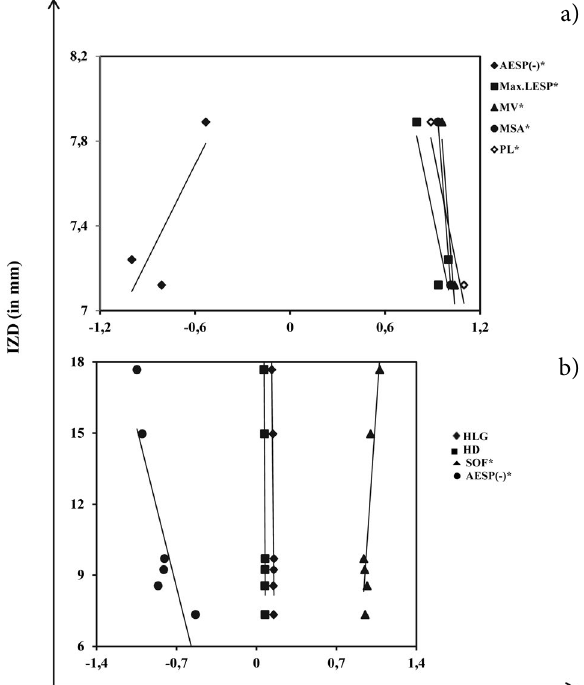
Figure 6. The correlation between descriptors and the IZD values of the ligands 4c , f , h and 4a – c , e , f , h against Gram-positive bacteria 1768 (a) and 1435 (b), respectively.